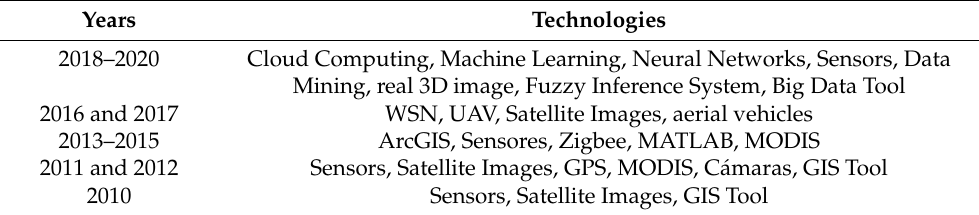
Table 9. Technologies most frequently used between the periods of the defined years.